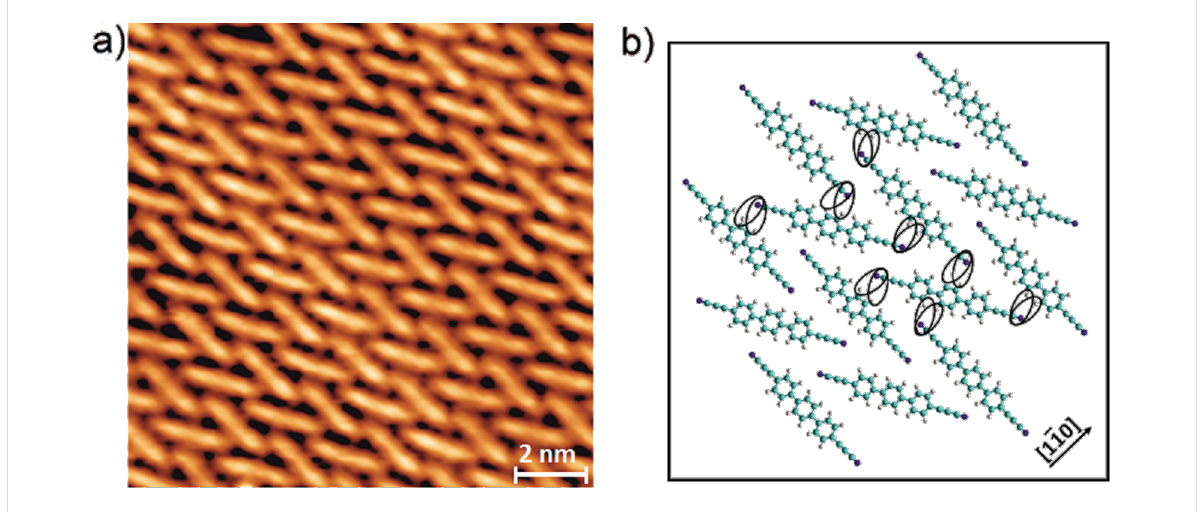
Figure 4: High-resolution STM image showing a) the molecular packing in chevron layers mediated by the propilonitrile end groups of the NC–C ≡ C–Ph 3 –C ≡ C–CN ( 2 ) linker (data measured at 6 K; image size: 119 × 119 Å 2 ; scanning parameters: V bias = 0.3 V, I = 0.05 nA); b) Corresponding model showing the interaction of adjacent propionitrile